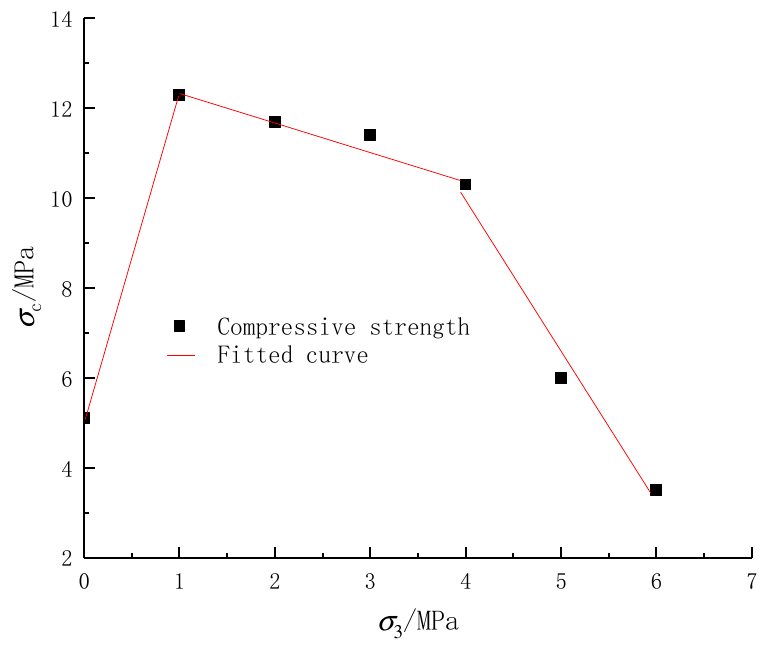
Figure 6. Stress-strain curve of coal samples under varied confining pressure after 3 cycles of liquid nitrogen injection.